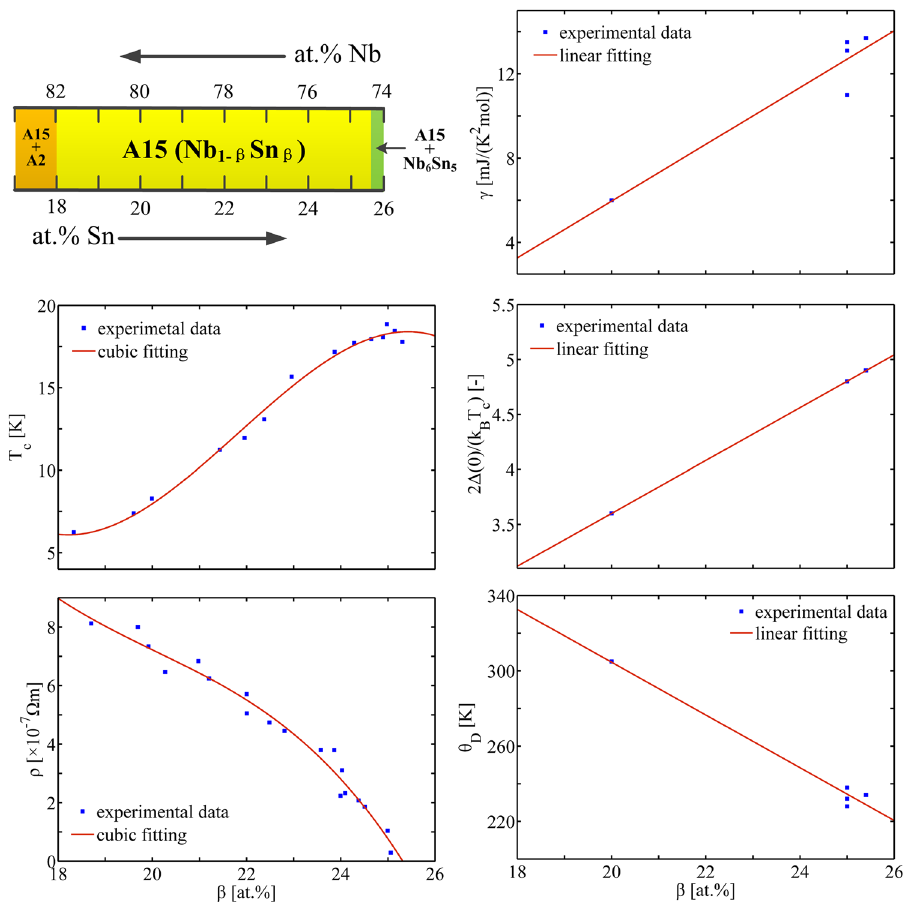
Figure 1. Variations of material parameters T c , ρ , γ , θ D and 2 Δ (0)/( k B T c ) with Sn content β in the A15 range of binary Nb 1 − β Sn β . The experimental data are extracted from ref. 3. The solid lines represent the global fits to the experimental data in the A15 range.